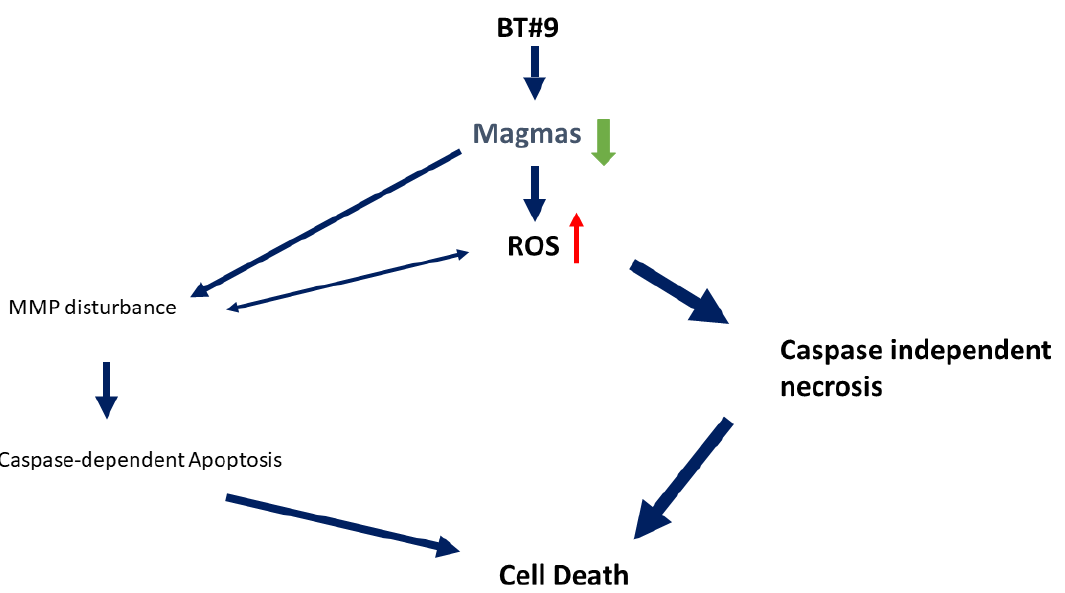
Figure 7. Schematic mechanism of BT#9 in prostate cancer cells. BT#9 downregulates Magma’s pro- tein and further activated mitochondria and intracellular ROS. ROS disturbs mitochondria membrane potential and induces apoptosis, but the main cell death of BT#9 induced cell death is caspase- independent necrosis.